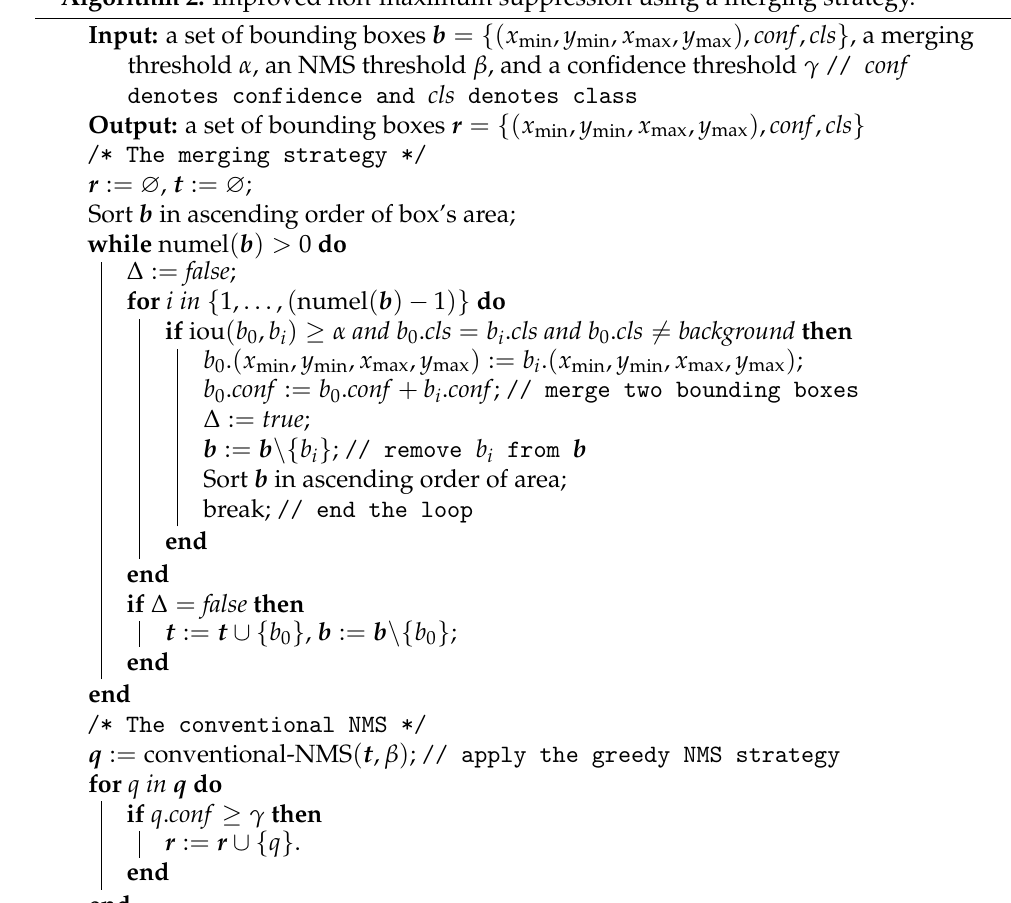
Algorithm 2: Improved non-maximum suppression using a merging